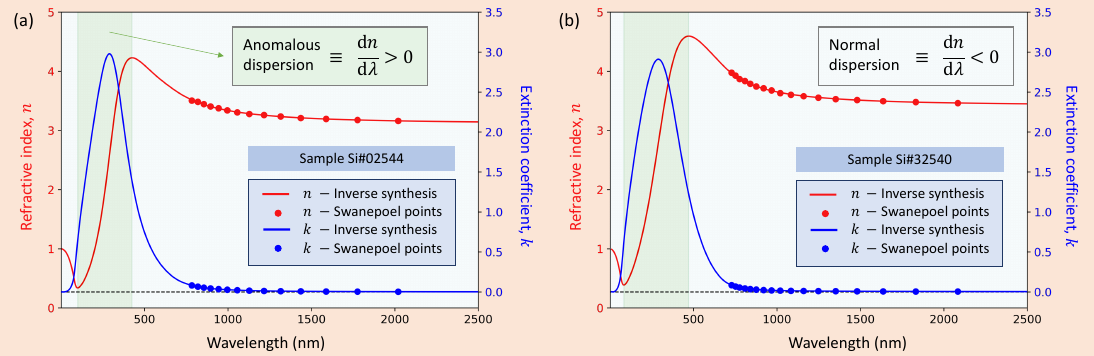
Figure 4. Refractive index, n , and extinction coefficient, k , versus wavelength, for a -Si thin layers (specimens ( a ) Si#02544 and ( b ) Si#32540), obtained by inverse synthesis, with the help of the holomorphic ATLU function adopted in this work. In addition, the values of n and k found by employing the model-free Swanepoel envelope technique are also shown for comparison in this